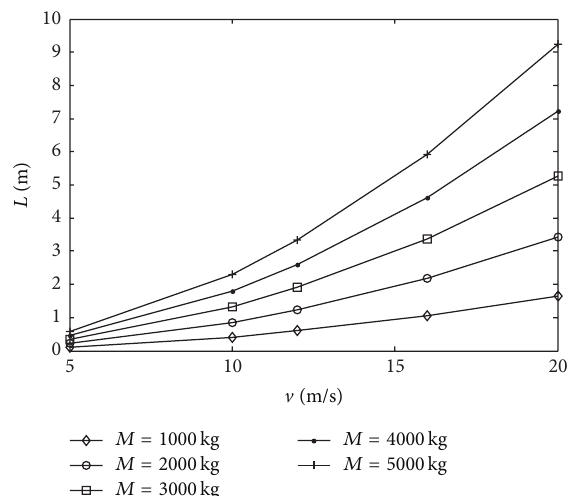
Figure 7: Tramcar braking distance change curves of different velocity.